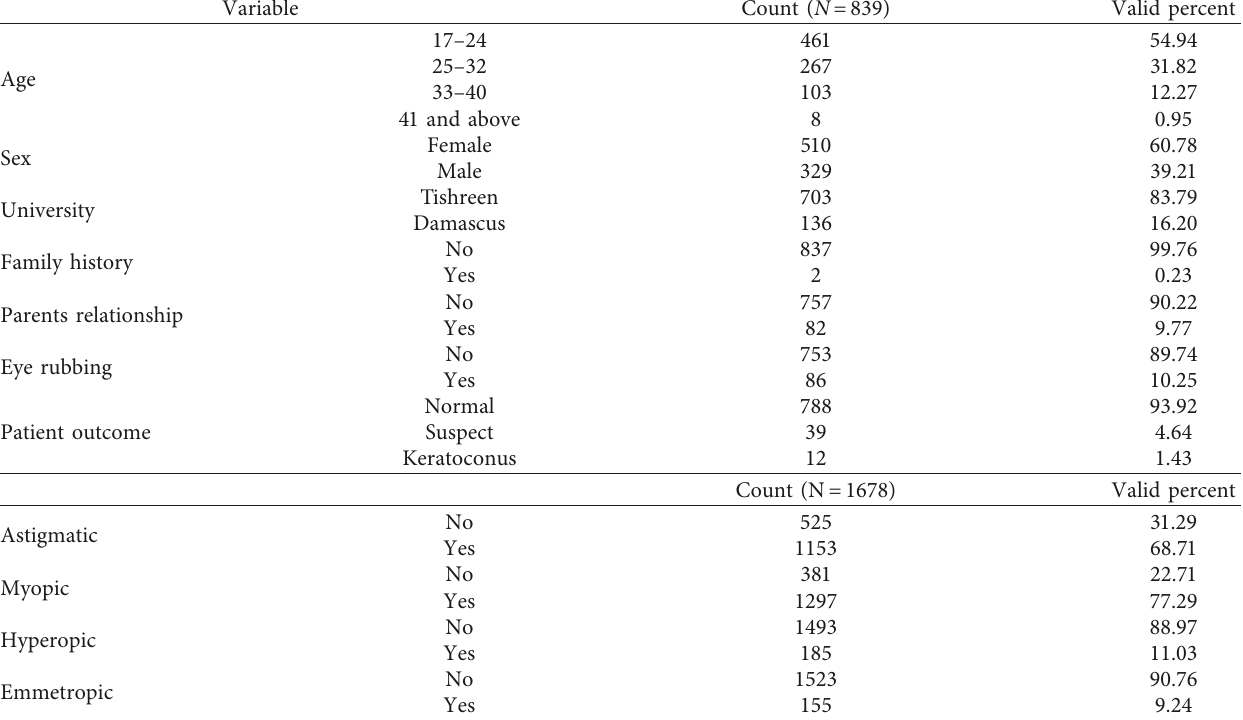
Table 1: Summary statistics of categorical variables.